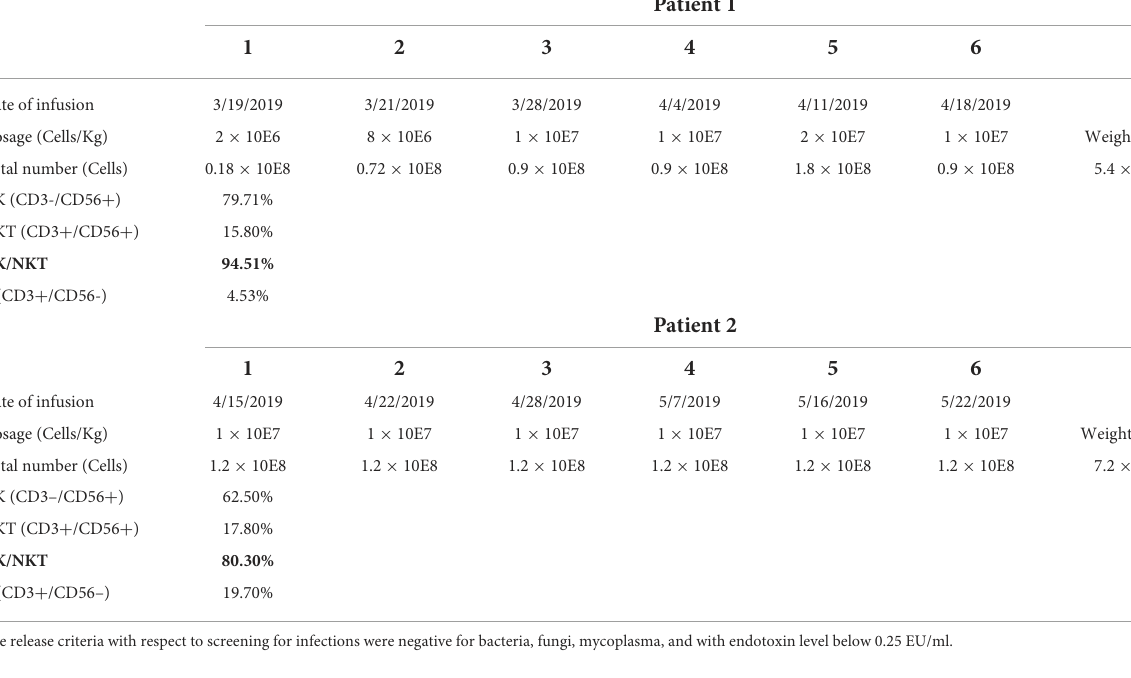
TABLE 1 The detailed information for NK cells infusion.